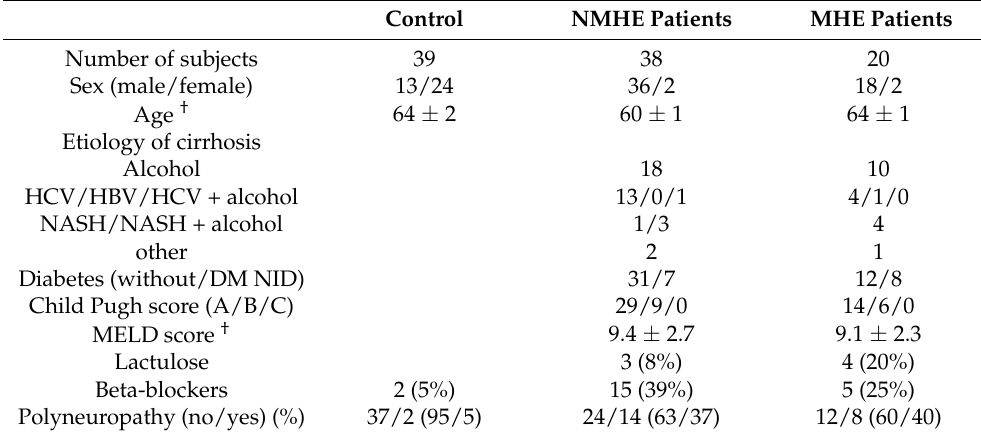
Table 1. Composition of the different groups and etiology of liver